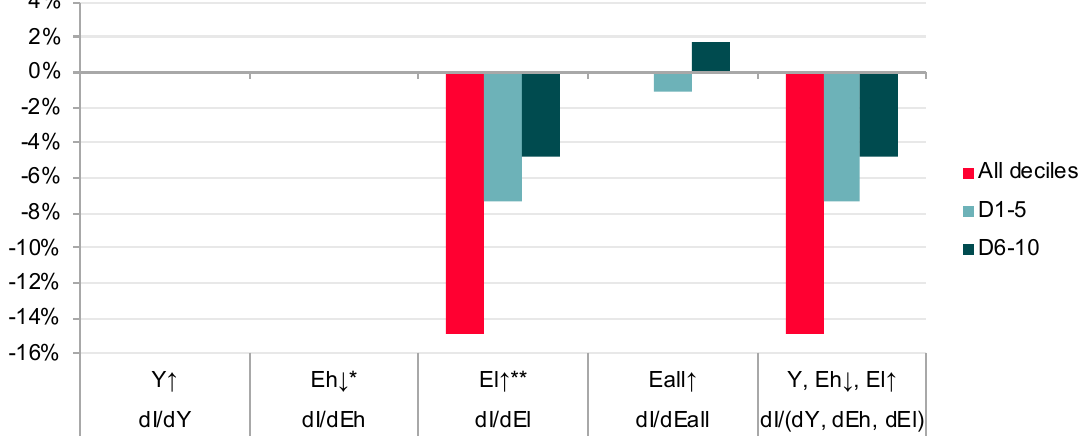
Figure 3. Results of sensitivity scenarios for LA indicator (10% change of indicator components). * high energy expenditure defined as above twice the national median expenditure. ** under-consumption defined as below half the national median expenditure. Arrows denote an ↑ increase and ↓ decrease.